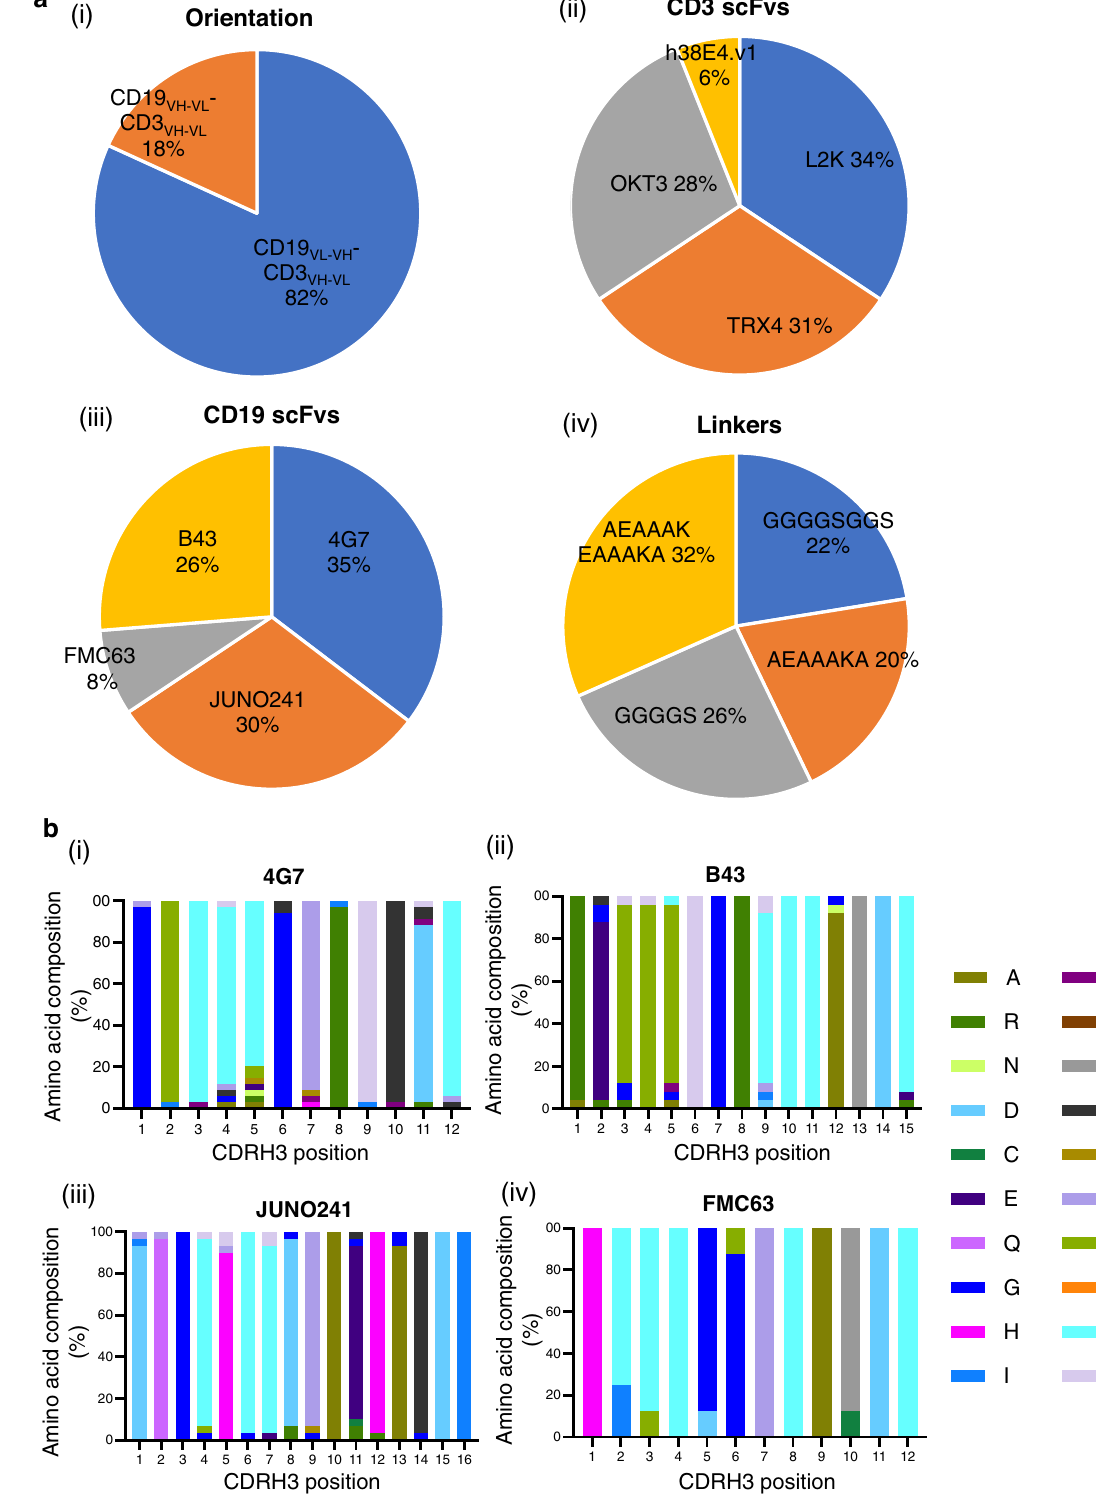
Fig. 7 Distribution of design parameters in the functionally active BiTE clones sorted using the single cell discovery platform. a Distribution of relative orientation of CD19 and CD3 scFvs (i), Distribution of CD3 scFvs (ii), Distribution of CD19 scFvs (iii), and linkers (iv) in the functionally active sorted library. The sequence of 99 functional BiTE clones (98 unique clones + 1 Blinatumomab sequence) elucidated by sanger sequencing was used for analyzing the distribution of design parameters. b CDRH3 composition of sorted BiTEs having a 4G7 (i), B43(ii), JUNO241 (iii) or FMC63 (iv) aCD19 scFv. CDRH3 compositions for each CD19 scFv type were analyzed from n = 34 4G7 containing BiTEs, n = 25 B43 containing BiTEs, n = 29 JUNO241 containing BiTEs, and n = 8 FMC63 containing BiTEs. Three clones were excluded from the CDRH3 analysis due to sequence ambiguity in the CDRH3